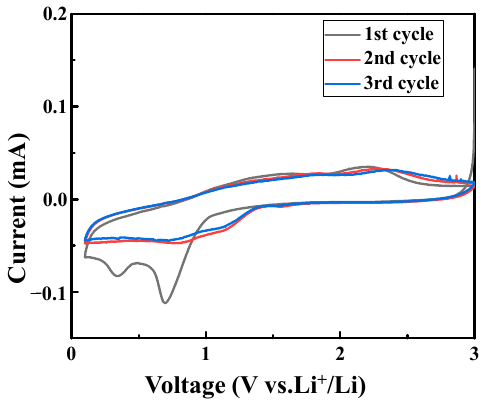
Figure 4. CV curves of ZnO/Co 3 O 4 .